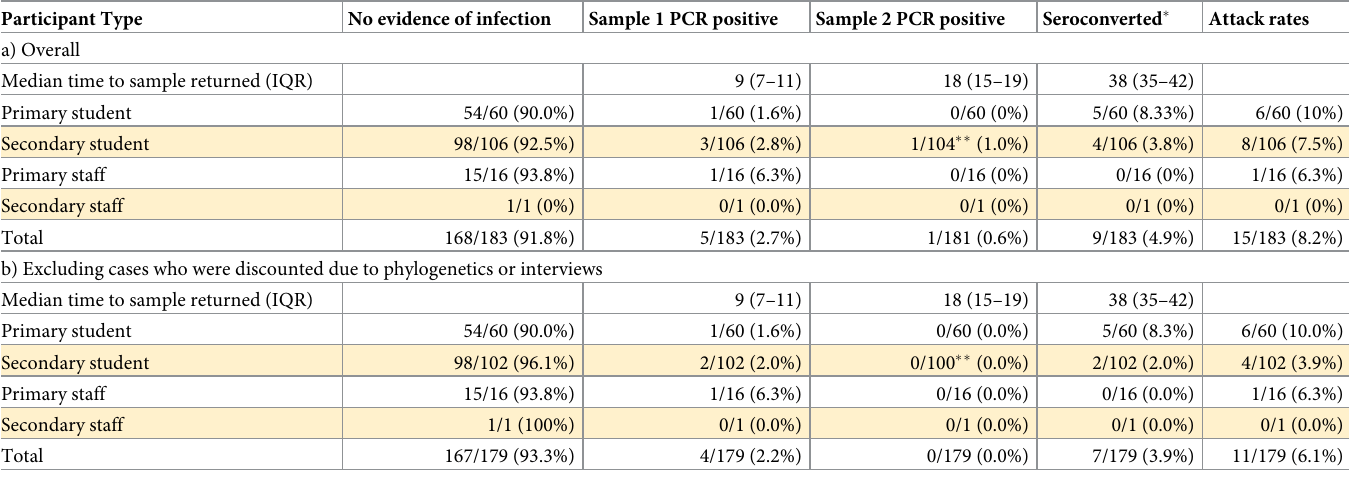
Table 4. Secondary attack rates of students and staff including only those that returned one RT-PCR sample and both oral fluid